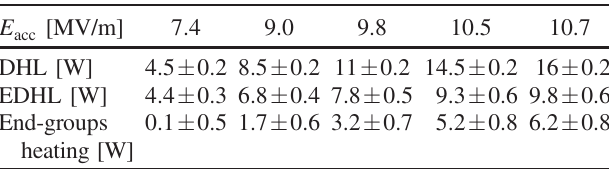
TABLE IV. EDHL and end-groups heating at 2 K vs DF.